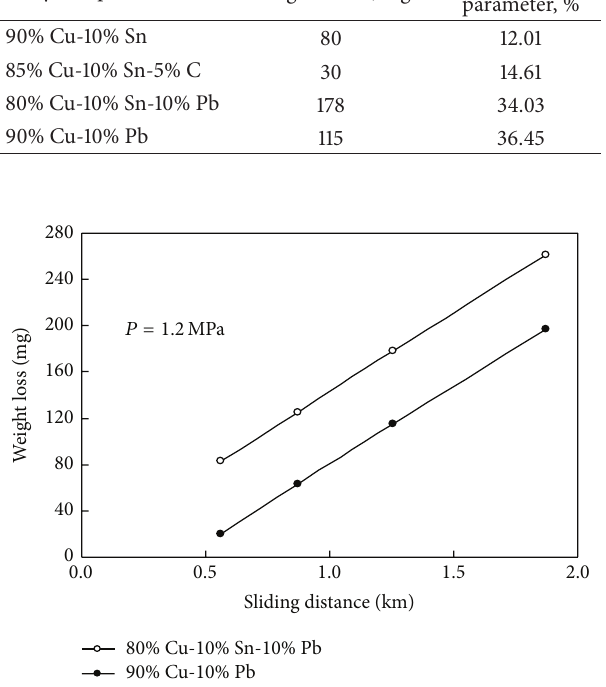
Figure 7: Weight losses in mg versus sliding distance in Km for the heat-treated 80% Cu-10% Sn-10% Pb and 90% Cu-10% Pb alloys.